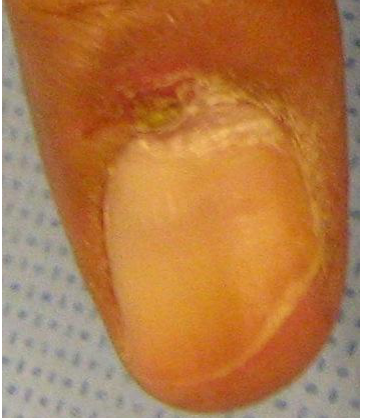
FIGURE 6 . Result after 16 weeks of conservative